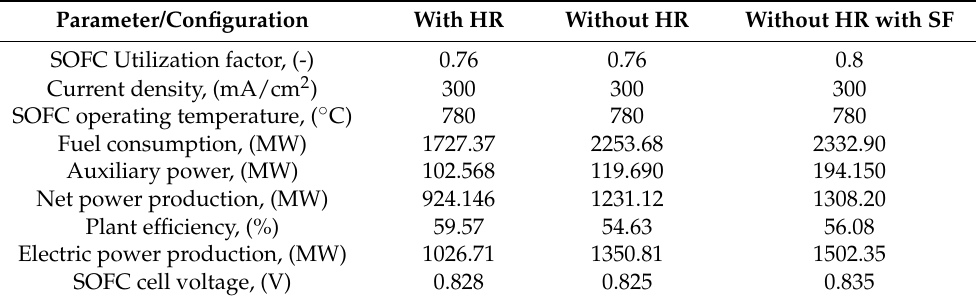
Table 7. Effect of HR on plant efficiency and